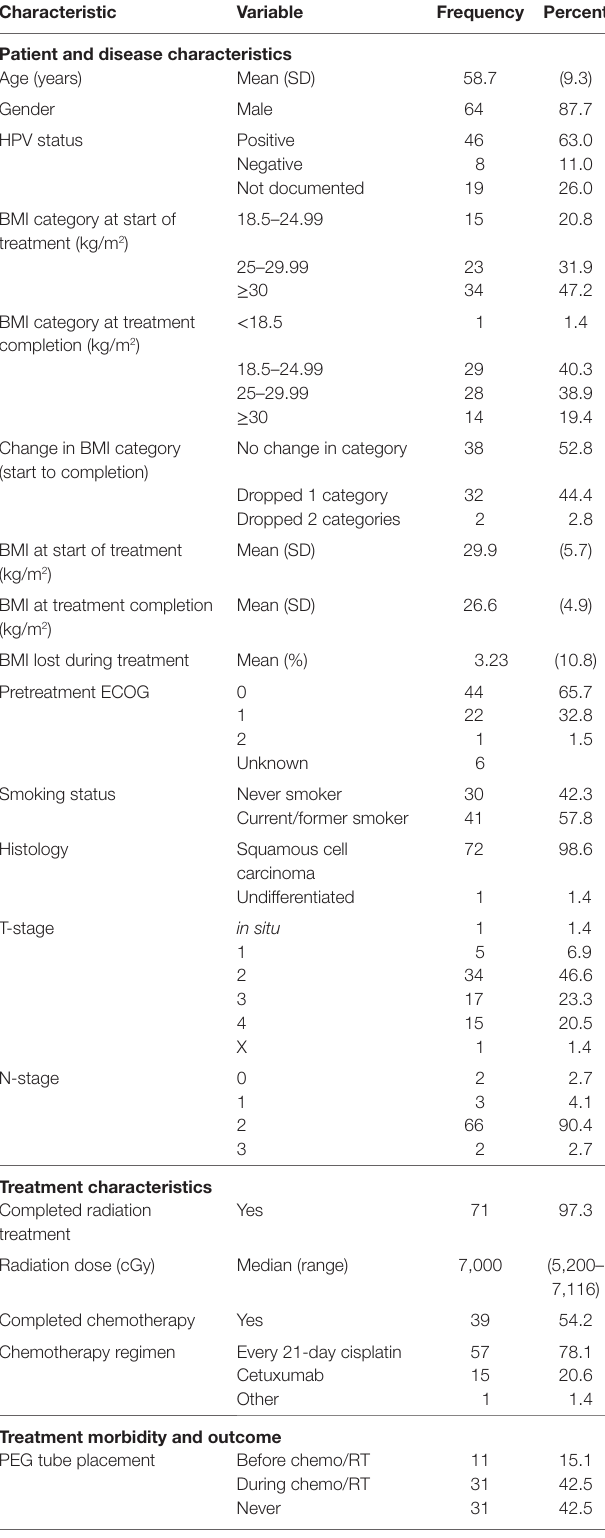
Table 1 | Characteristics of patients, disease, treatment, and outcomes ( n =